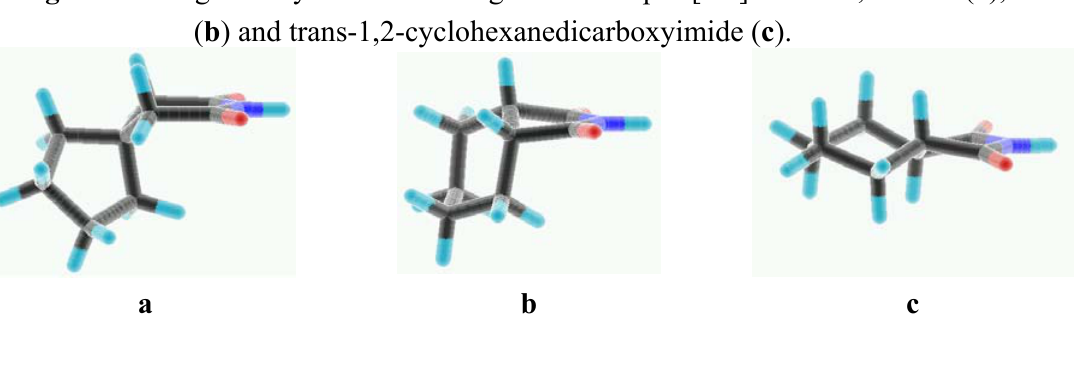
Figure 2 . The geometry of terminal fragments: azaspiro[4.5]decane-7,9-dione ( a ), cis- ( b ) and trans-1,2-cyclohexanedicarboxyimide ( c ).